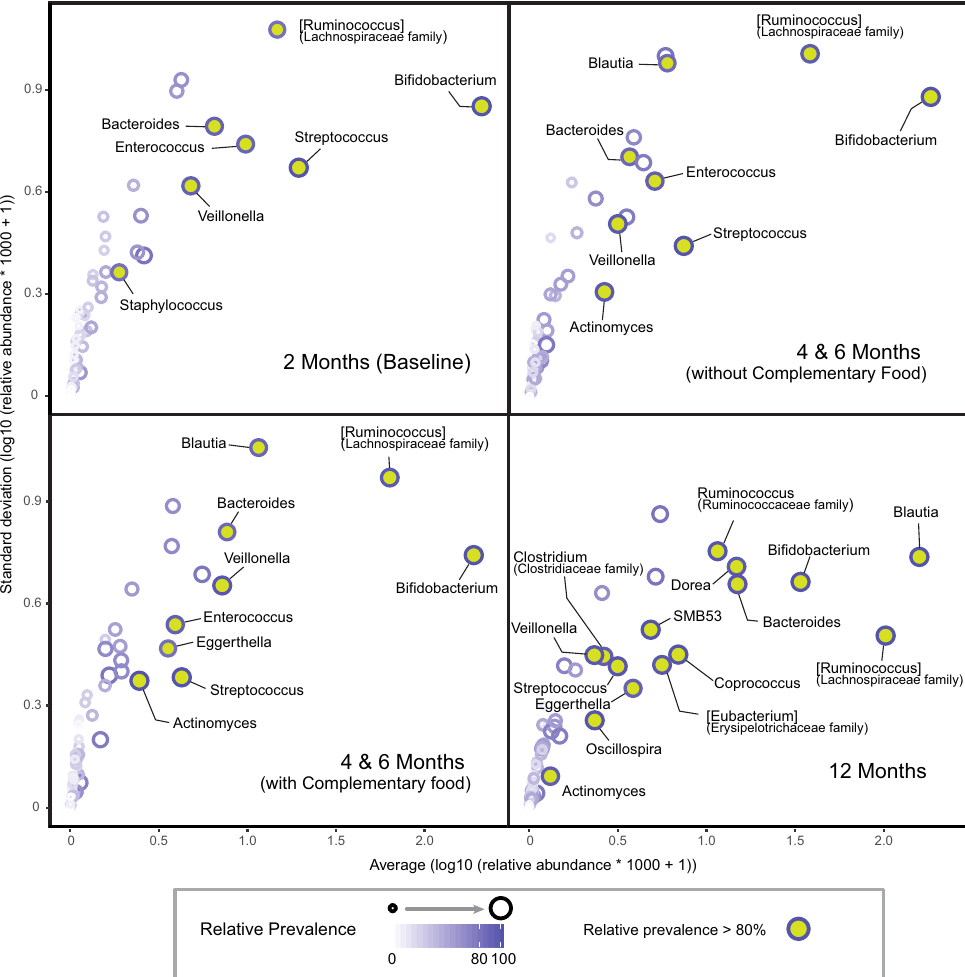
Figure 1. The core fecal microbiota of infants. The core microbiota is defined as highly prevalent microbes at the genus level present in > 80% of